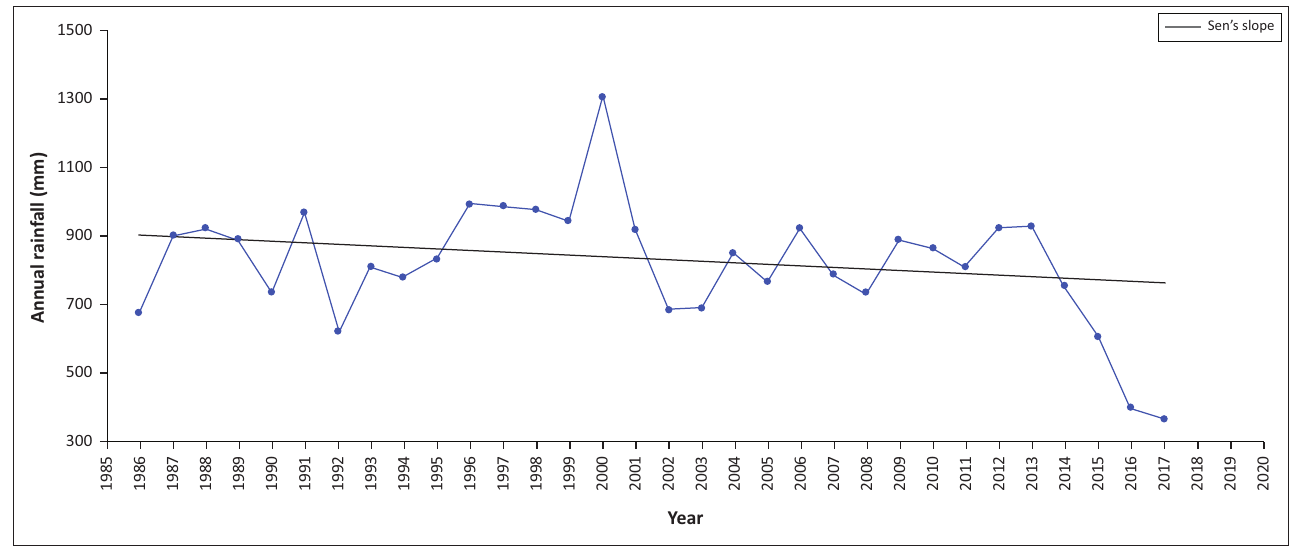
FIGURE 3: Annual rainfall trend for Eswatini (1986–2017).